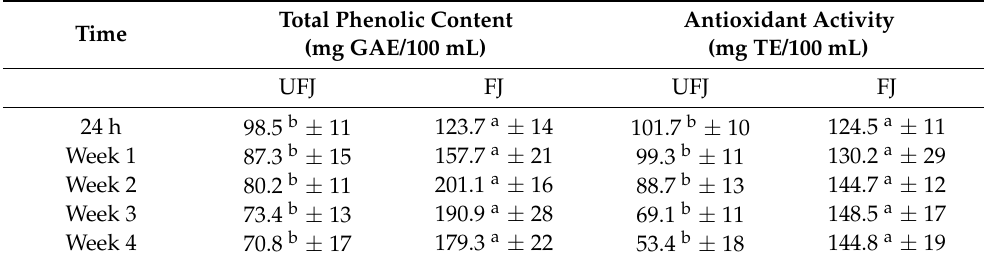
Table 2. Determination of the total phenolic content and antioxidant activity of unfermented (UFJ) and fermented pomegranate juice (FJ) with L. paracasei SP3 for the first 24 h at 30 ◦ C and during storage at 4 ◦ C for 4